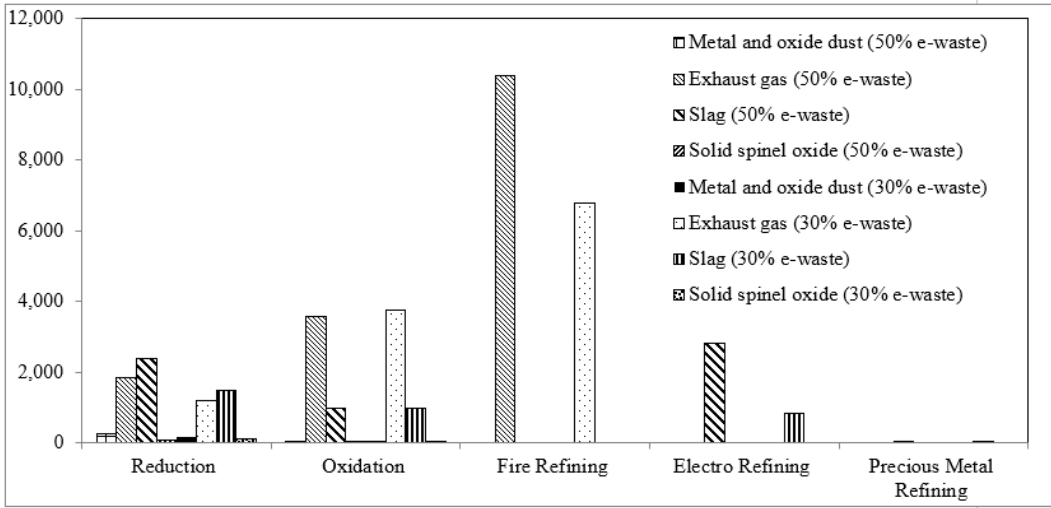
Figure 7. Waste gas emission rate (t/h). Figure 8 made a comparison between the solid and gas waste emission generated by the two major process units (reduction and oxidation furnace) in e-waste treatment. As can be seen from Figure 8, it is estimated that almost 2200 t of solid spinel oxide dust, 41,000 t of slag, and 3600 t of metal and oxide dust was generated annually in the reduction furnace when the percentage of e-waste in the feed is 50 wt%. From this, 3000 t was further recycled to recover Ni, Sn, etc., and slag was partially reused in a closed loop back to the reduction and oxidation furnaces, with the rest being landfilled.